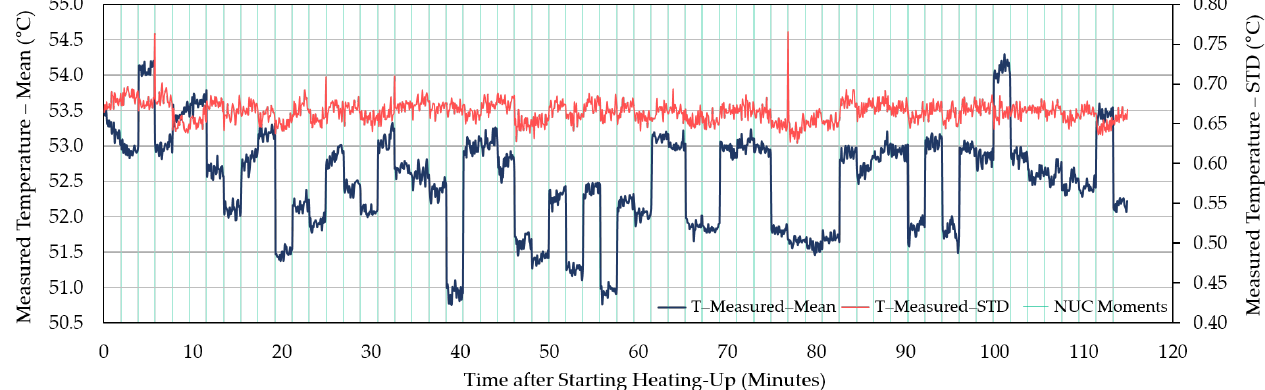
Figure 4. The measured average temperature of the blackbody calibrator (55 °C) area, as recorded by WIRIS 2nd GEN over 2 h after switching on the camera. The STD of the measured temperature is also included. In this session, the NUCs were enabled every 2 min .